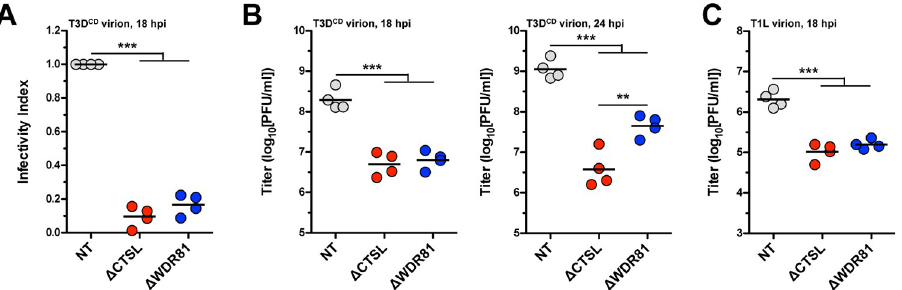
Fig 3. Infectivity of T3D CD and T1L virions in WDR81-deficient cells. (A) Levels of infectivity. NT, Δ CTSL, and Δ WDR81 cells were infected with T3D CD virions at 5 PFUs/cell. At 18 hpi, the infectivity index was measured using indirect immunofluorescence. Horizontal bars indicate the means; ��� , P � 0.0005 (n = 4 biological replicates). (B and C) Production of infectious virus. NT, Δ CTSL, and Δ WDR81 cells were infected with T3D CD (B) or T1L (C) virions at 5 PFUs/cell. At 18 and 24 hpi, the amount of infectious virus produced was measured using plaque assay. Horizontal bars indicate the means; �� , P � 0.005, ��� , P � 0.0005 (n = 4 biological replicates).